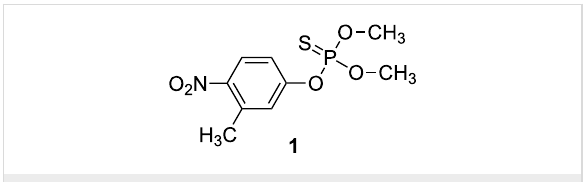
Figure 1: Chemical structure of fenitrothion ( 1 ).